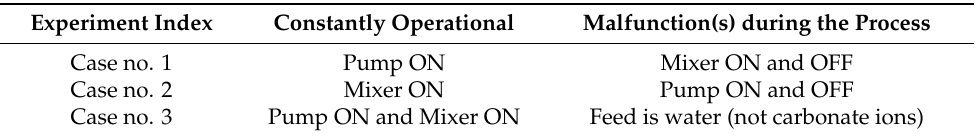
Table 3. The investigated scenarios for fault detection and diagnostics with electrode no. 2 of the ERT system. All the experiments are carried out at a mixing speed of 100 RPM and feed addition rate of 40 mL min (cid:2879)(cid:2869) .